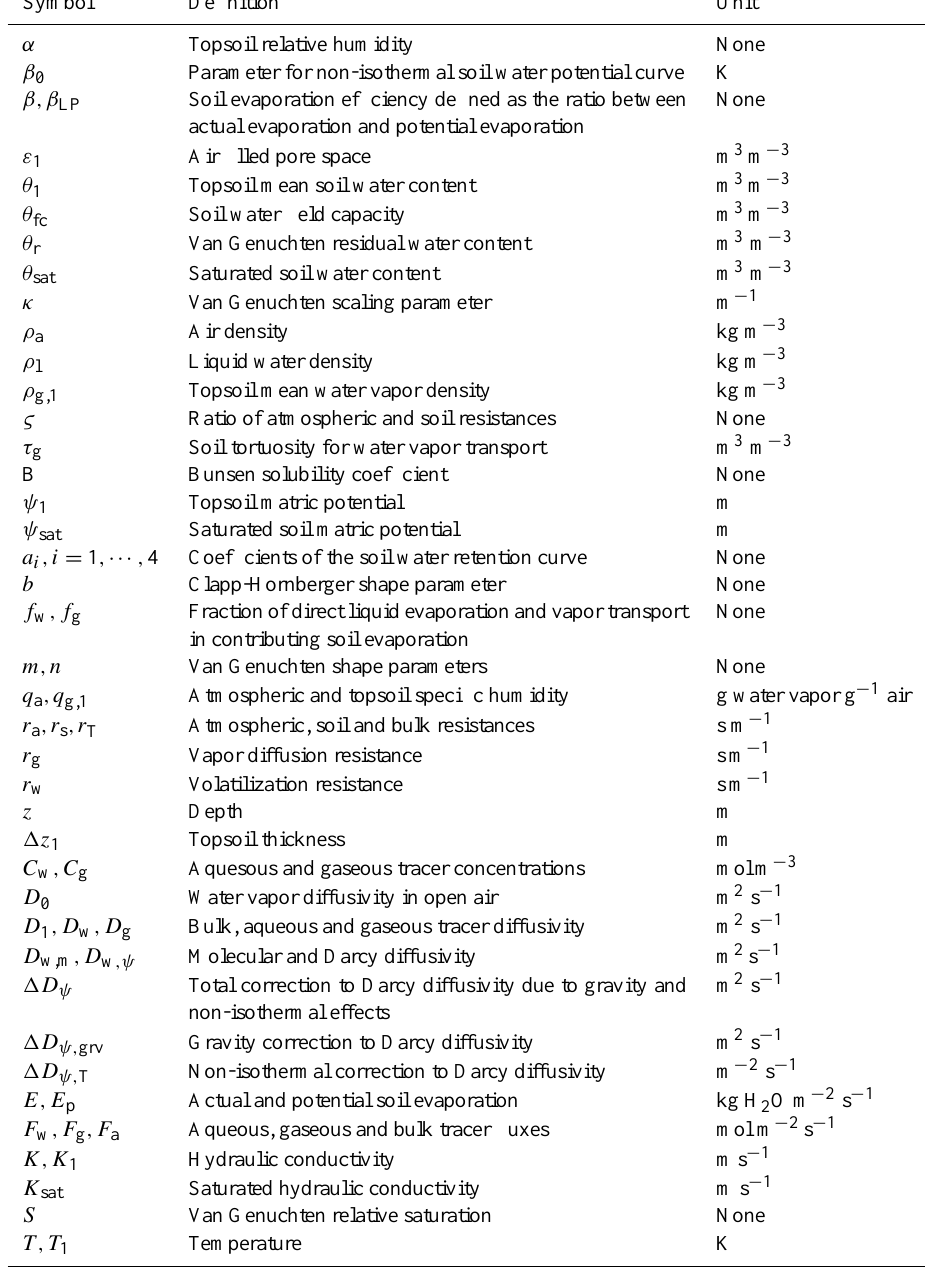
Table A1. Symbol Definition Unit α Topsoil relative humidity None Parameter for non-isothermal soil water potential